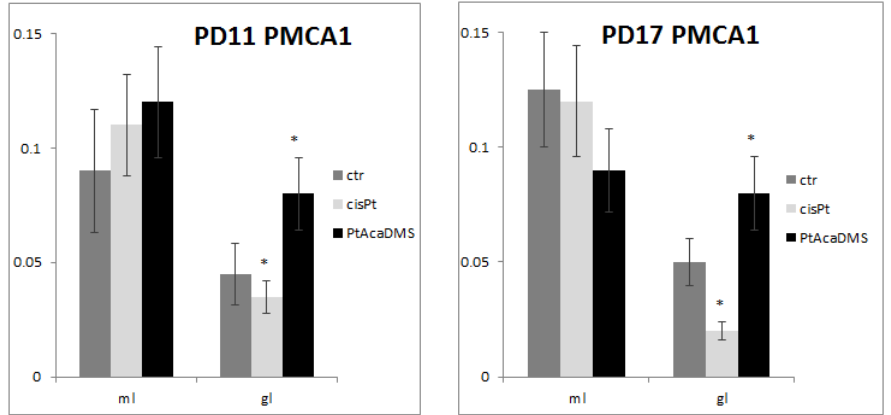
Figure 4. PMCA1 immunocytochemistry in the DG granule cell layer. Histograms show the OD values and the significance of differences is reported (* p <0.05). At PD11 , the